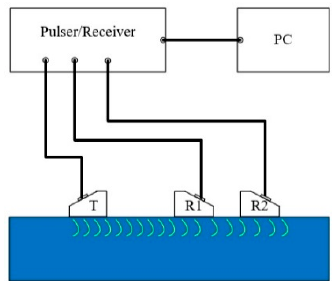
Schematic of the experimental critically refracted longitudinal (L CR ) wave system (T: transmitting transducer, R1: the first receiving transducer, R2: the second receiving transducer, and PC: personal computer).